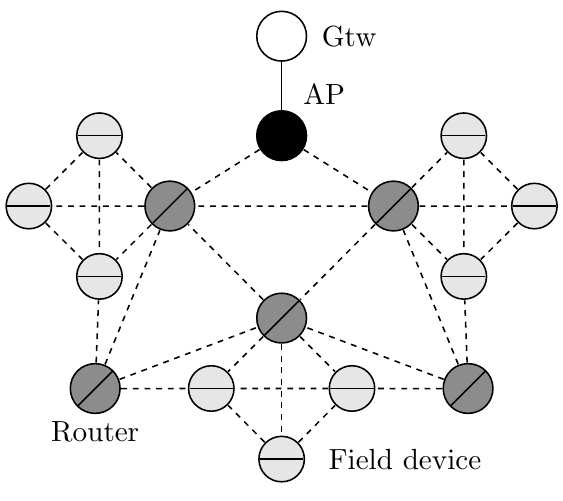
Figure 22. Adding router devices to improve reliability and availability.